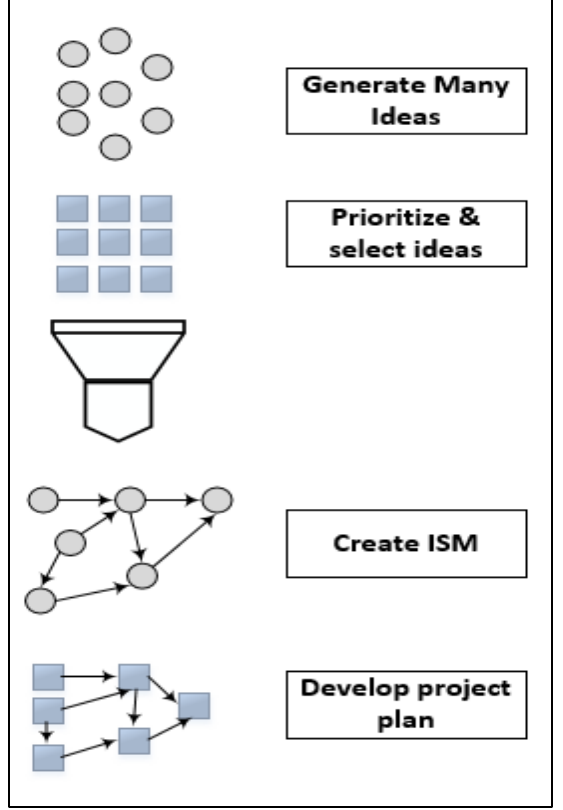
Fig. 1. High Level View of ISM Process (Adopted